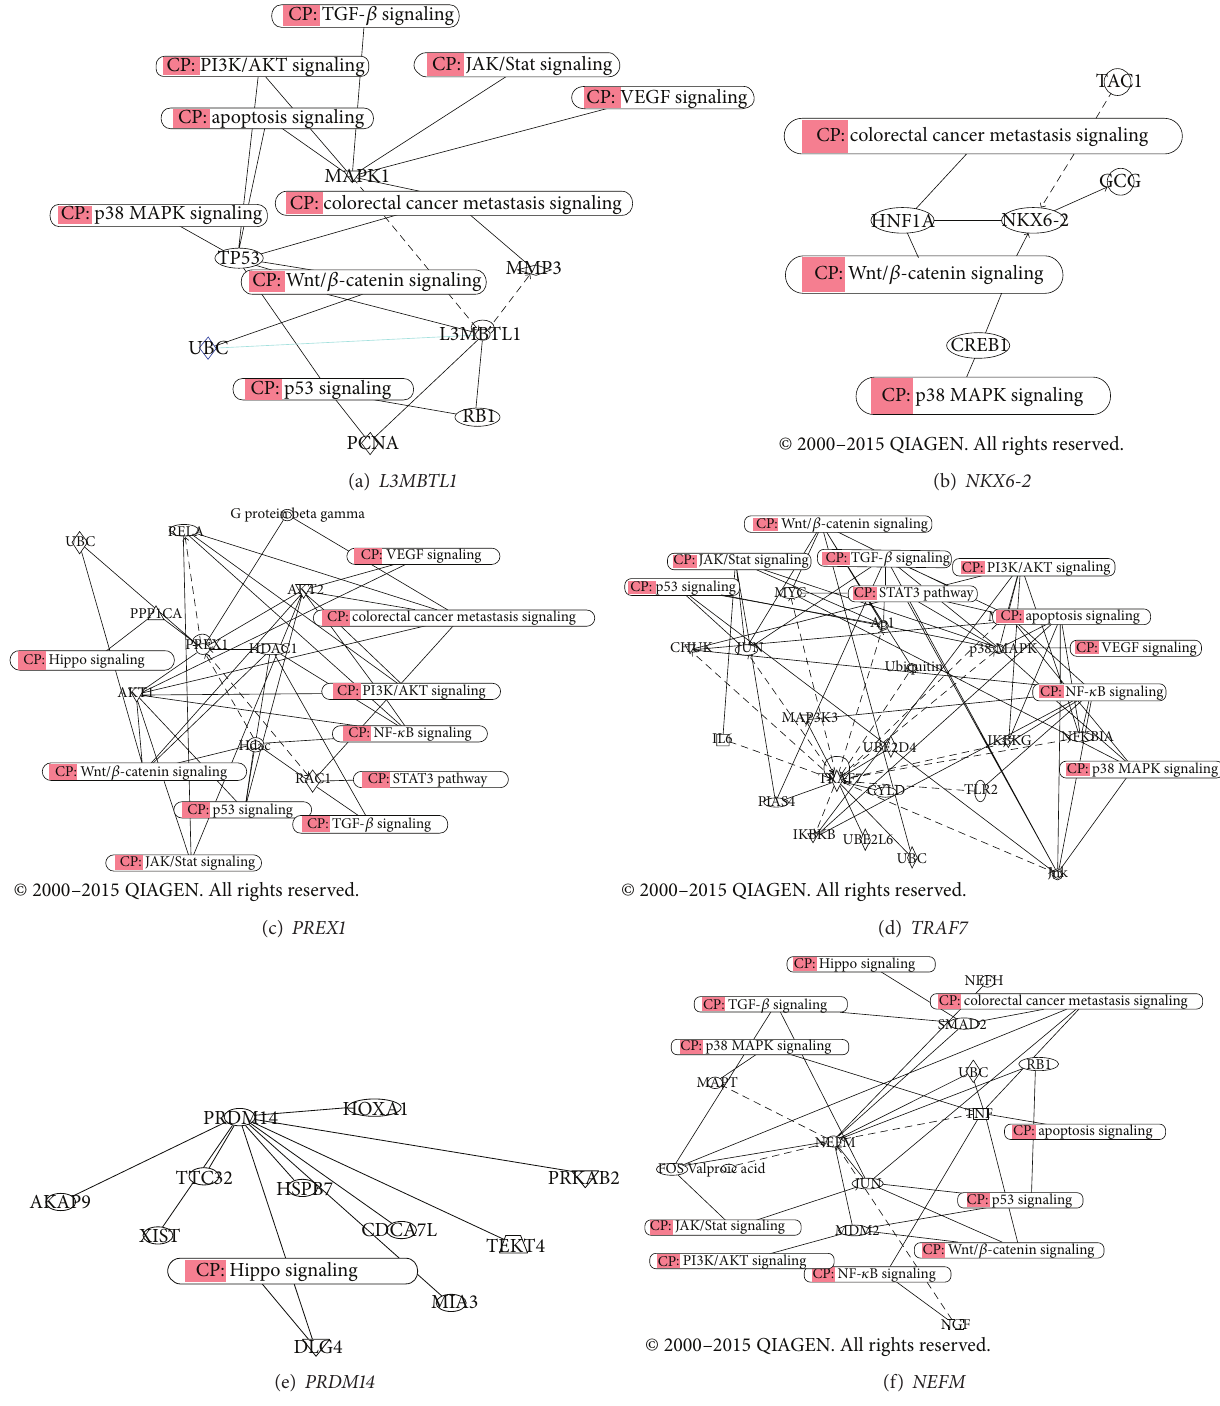
Figure 2: Ingenuity Pathways Analysis of the identified methylated targets. L3MBTL1 (a), NKX6-2 (b), PREX1 (c), TRAF7 (d), PRDM14 (e), and NEFM (f). CP: Conical